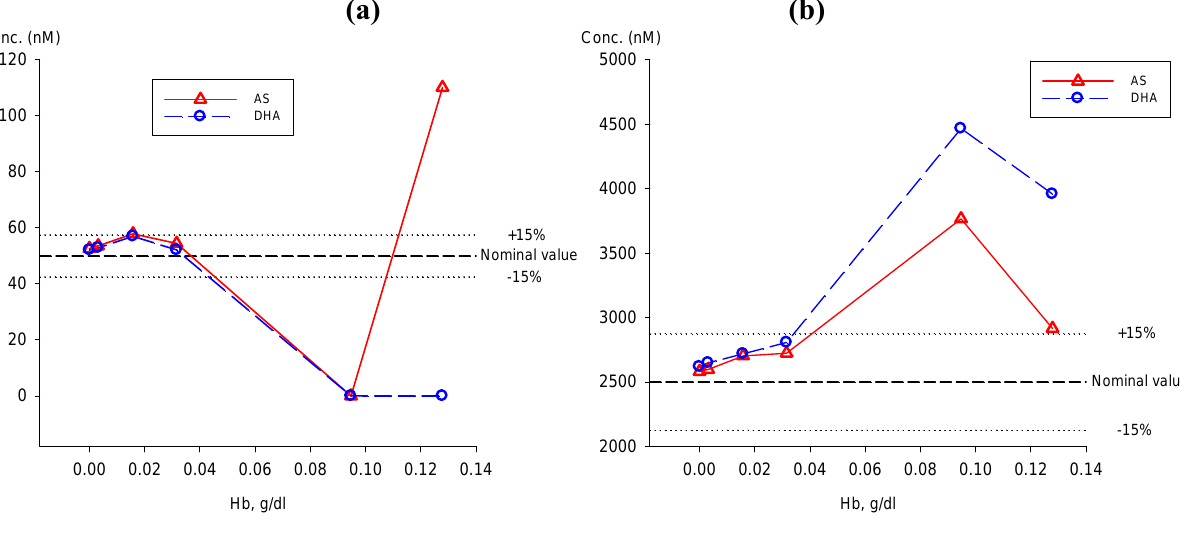
Figure 10. Application to clinical plasma samples in plasma from three patients following IV AS treatment (2.4 mg/kg) using the validated assay and cross-validation of AS ( Δ ) and DHA ( o ) by external standard (solid lines) method compared to internal standard method using ARN as IS (broken lines). Values are mean +